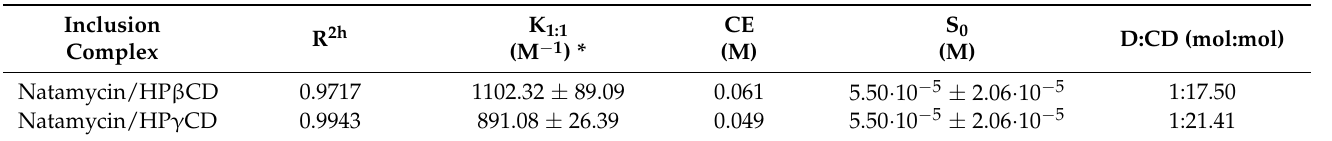
Table 3. Values for K1:1, CE, and the D:CD ratio, obtained from the natamycin/cyclodextrin complex in water at 25 ◦ C.